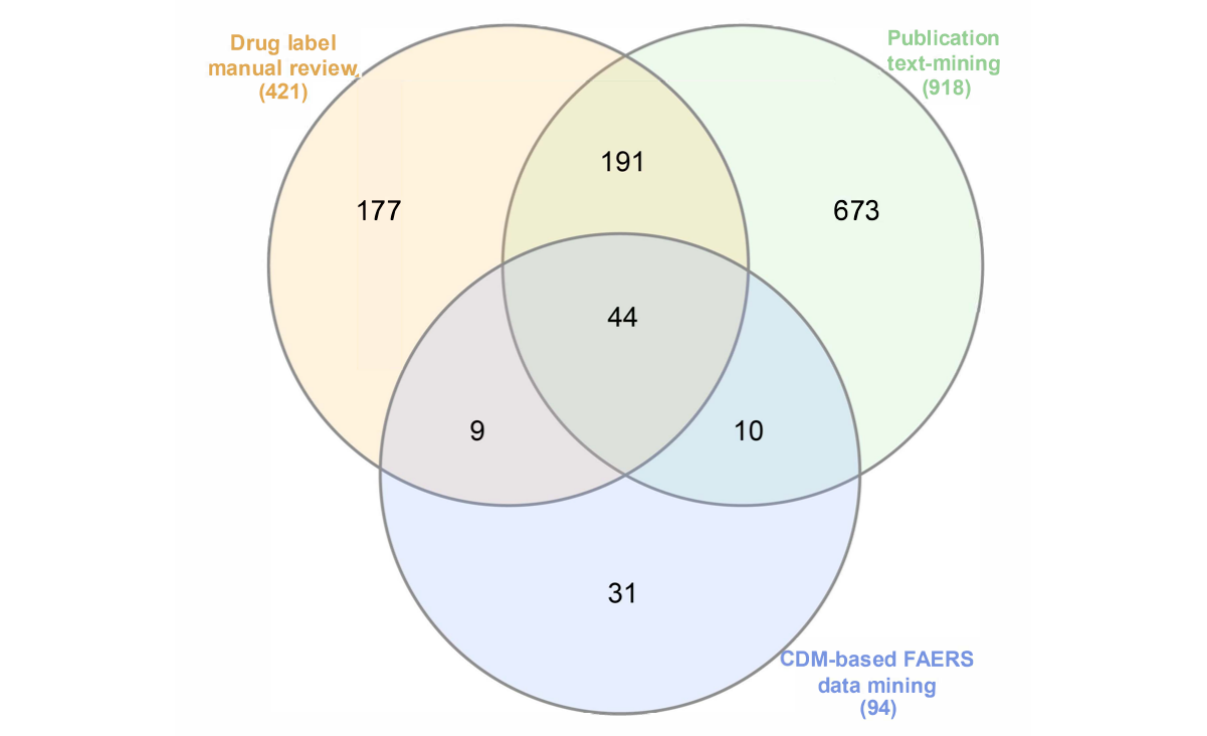
Figure 4. Venn diagram illustrating the immune-related adverse events terms detected from different sources. CDM, common data model; FAERS, Food and Drug Administration’s adverse event reporting